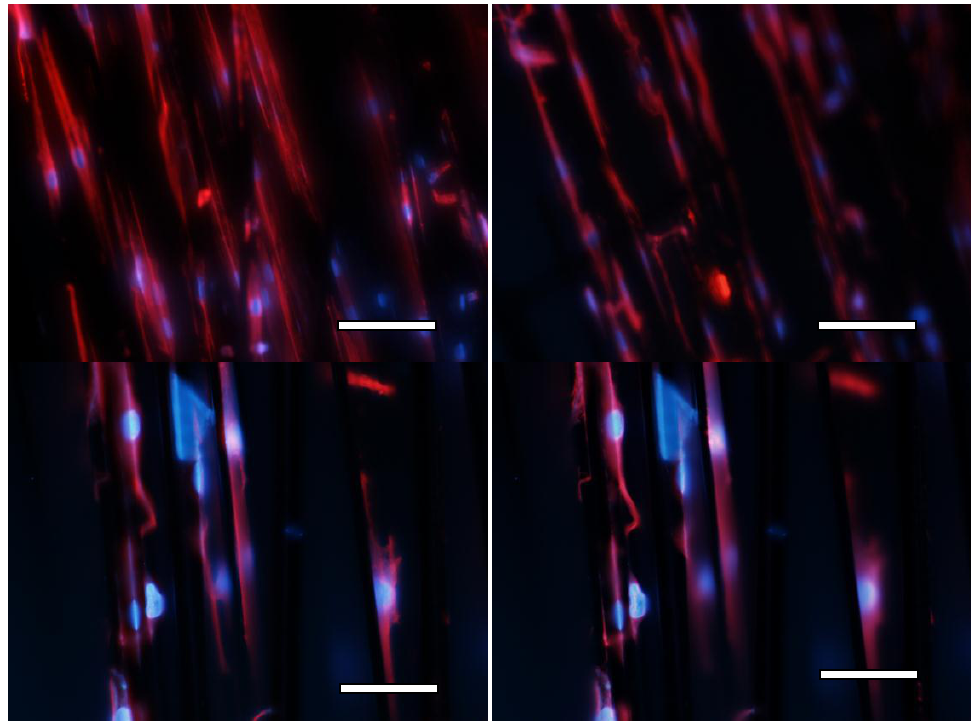
Figure 6. The cells attached and spreading upon the carbon fibrils functionalized with hMSC-CM show a good energetic behavior and adequate viability. Fluorescent dyes: α-tubulin (red for the cytoskeleton) and DAPI (blue for the nuclei). Upper images scale bar: 100μm. Lower images scale bar: 200μm.